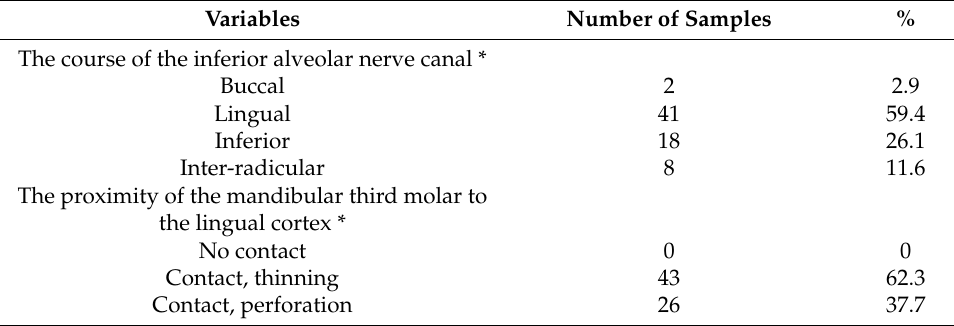
Table 2. Characteristics of radiographic signs in the exposed group.